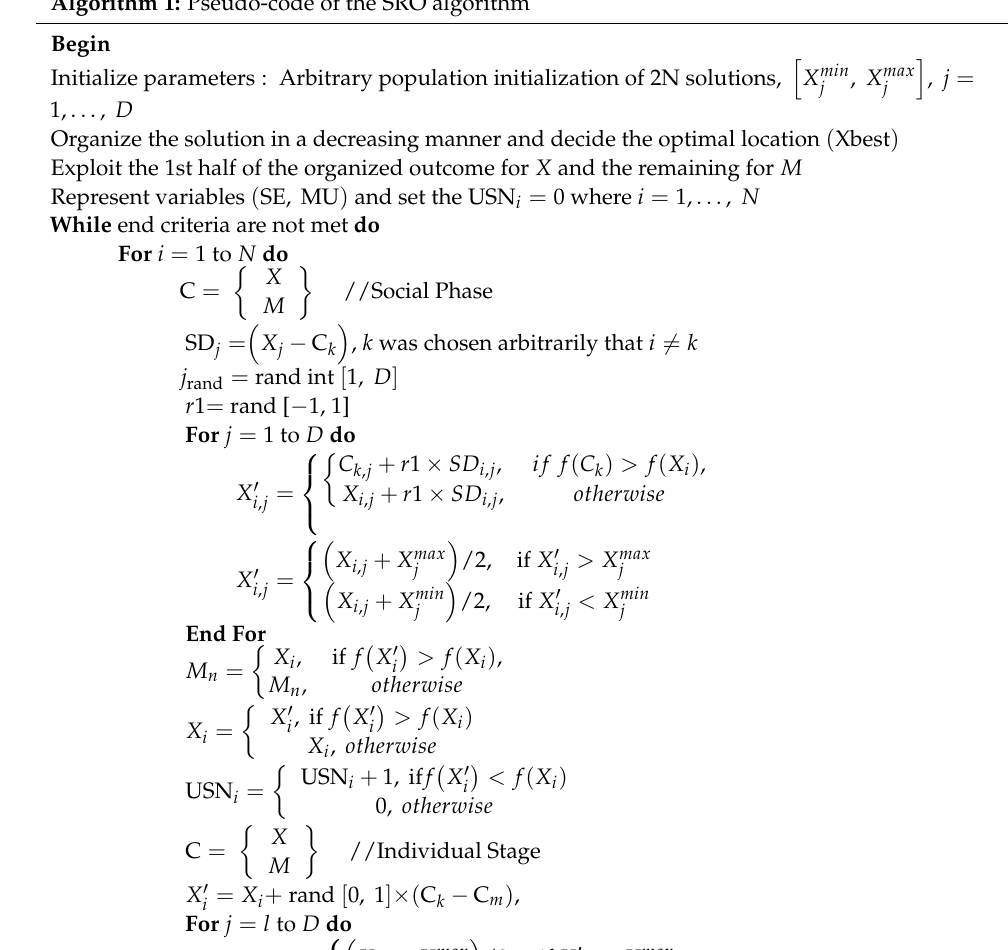
Algorithm 1: Pseudo-code of the SRO